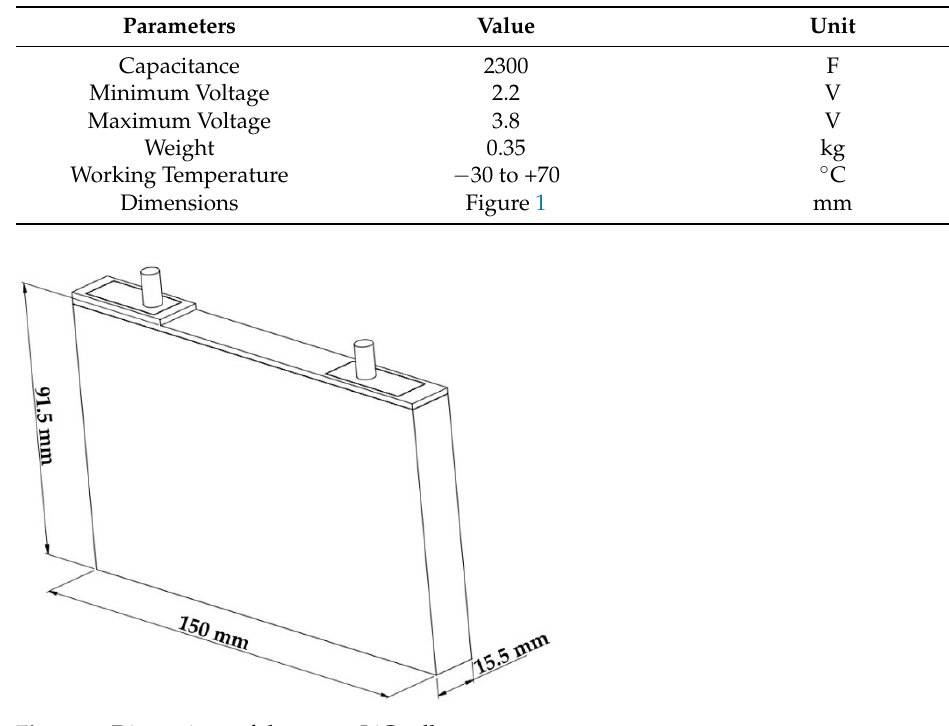
Figure 1. Dimensions of the target LiC cell.